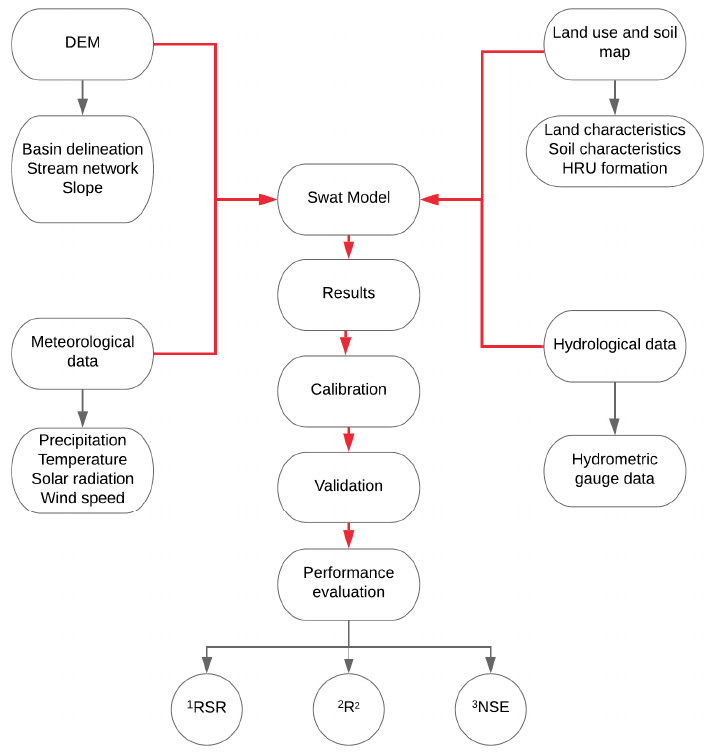
Figure 2. SWAT model structure. 1 The ratio of the Root-Mean-Square Error (RMSE) to the standard deviation of measured data (RSR); 2 coefficient of determination R 2 ; and 3 Nash–Sutcliffe efficiency (NSE).